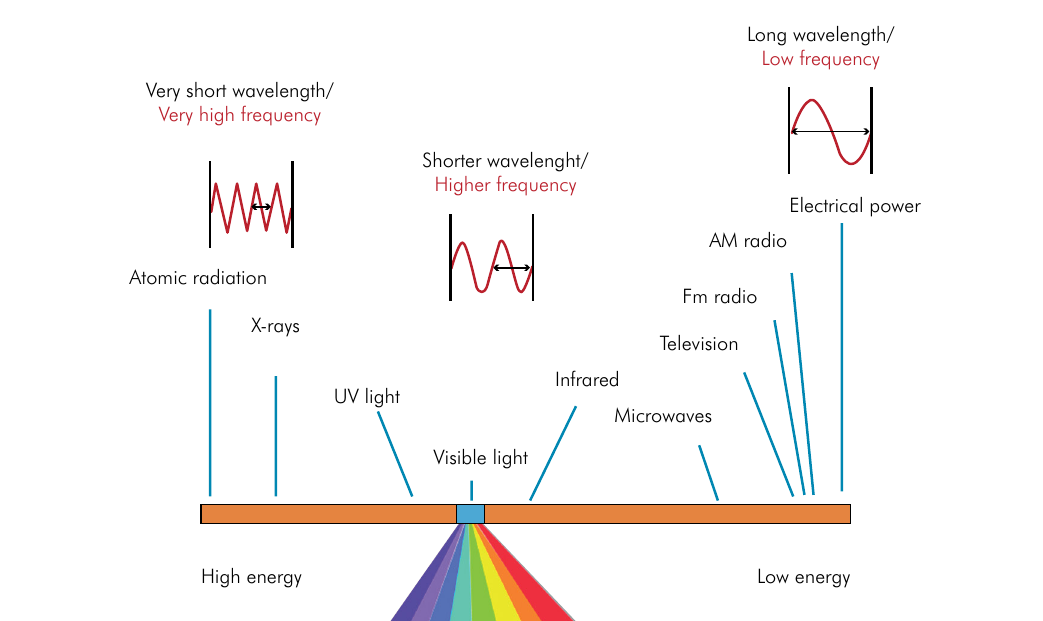
Figure 6. Electromagnetic spectrum with correlated depictions of trends in frequency and wavelength, as well as energy content and location of commonly used band